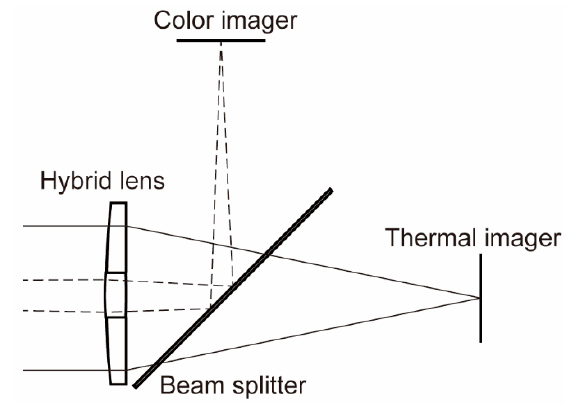
Figure 1. Schematic drawing of the proposed coaxial optical system.